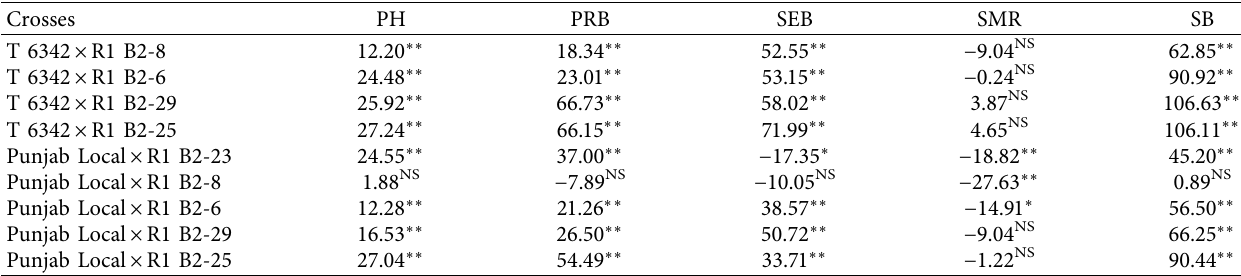
Table 17: Standard (economic) heterosis of mustard hybrids for yield and its attributed traits. Crosses TOS